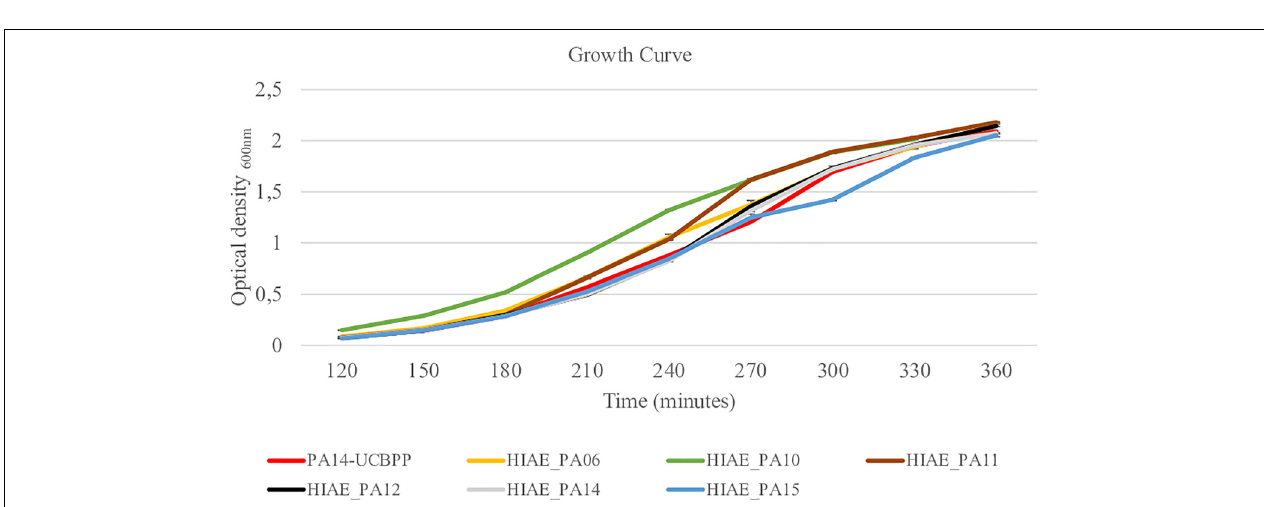
FIGURE 2 | Growth curves for reference strain PA14-UCBPP and clinical isolates. N = 10.